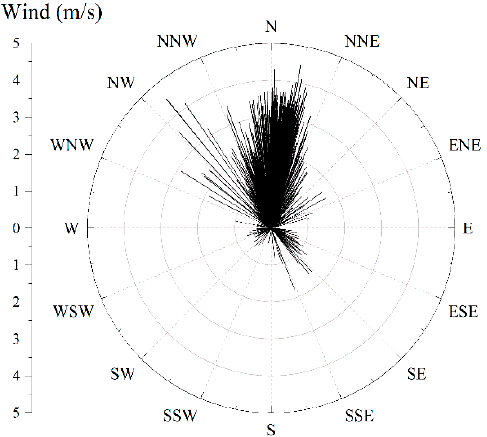
Figure 11. Correlation of wind direction and wind speed at Shanglan at night.